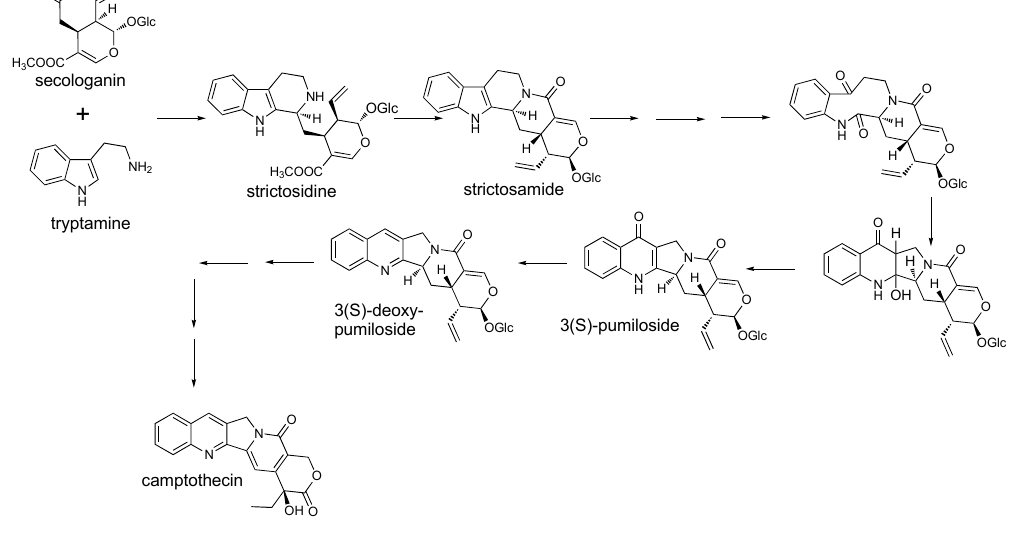
Figure 2. Proposed steps in the intermediate and late stages of camptothecin